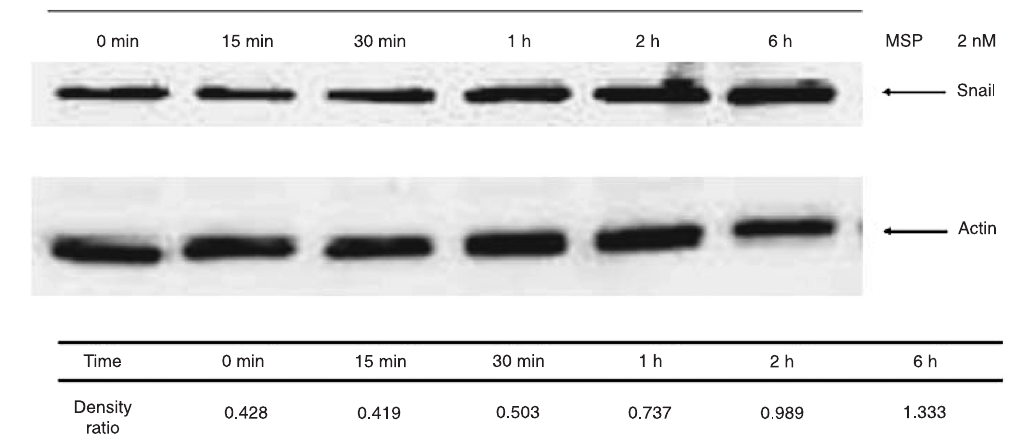
Figure 5. Changes of Snail expression in macrophage stimulating protein (MSP)-stimulated RE7 cells. Cellular proteins from 2 nM MSP-stimulated RE7 cells were probed in Western blots using 5 antibodies specific for Snail (from 0, to 15 and 30 min, and after 1, 2, and 6 h). The expression level of Snail was shown by the relative density ratio of Snail and